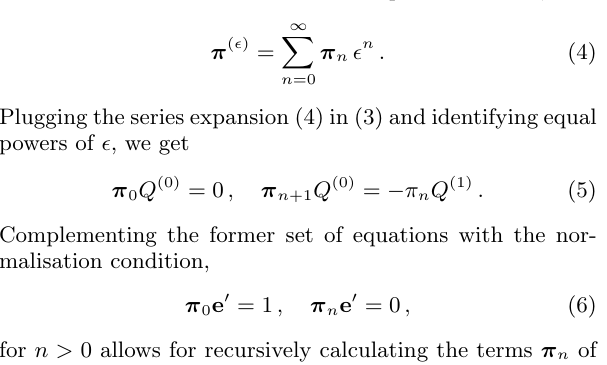
mission channel. Let M = { 1 , 2 , . . . , M } be the state space of this Markovian background process and let α ij denote the transition rate from state i to state j , i (cid:54) = j , i, j ∈ M